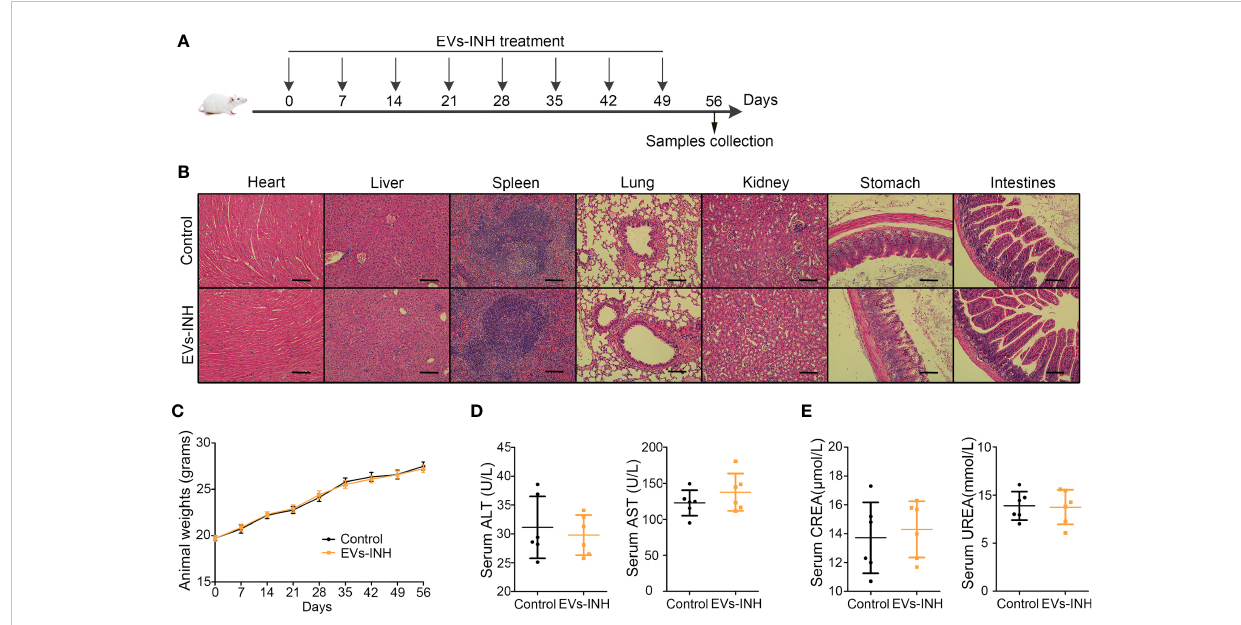
FIGURE 8 Biocompatibility evaluation of EVs-INH (n=6). (A) Schematic diagram for EVs-INH treatment. (B) HE staining, scale bar=100 m m, and the images are shown at ×200. (C) Mouse body weights. Indicators re fl ected the physiological function of the (D) liver (ALT and AST) and (E) kidney (CREA and UREA) were detected. ALT, glutamic pyruvic transaminase; AST, glutamic oxaloacetic transaminase; CREA, Creatinine. Each dot represents data from one animal and n = 6 per group. Student ’ s